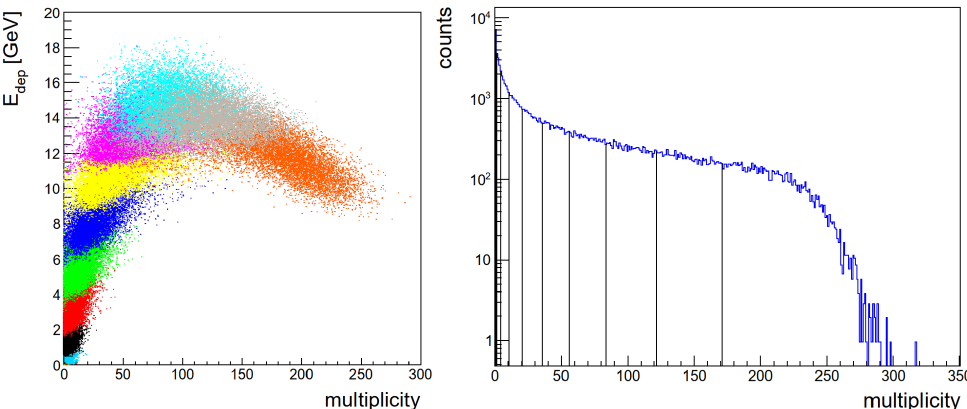
Figure 3. Left — correlation between the energy deposition in FHCal and track multiplicity in TPC. Each color corresponds to 10% centrality class determined in FHCal, see Figure 2. Right — charged-particles multiplicity distribution in TPC divided into 10 parts, with 10% of events in each part.